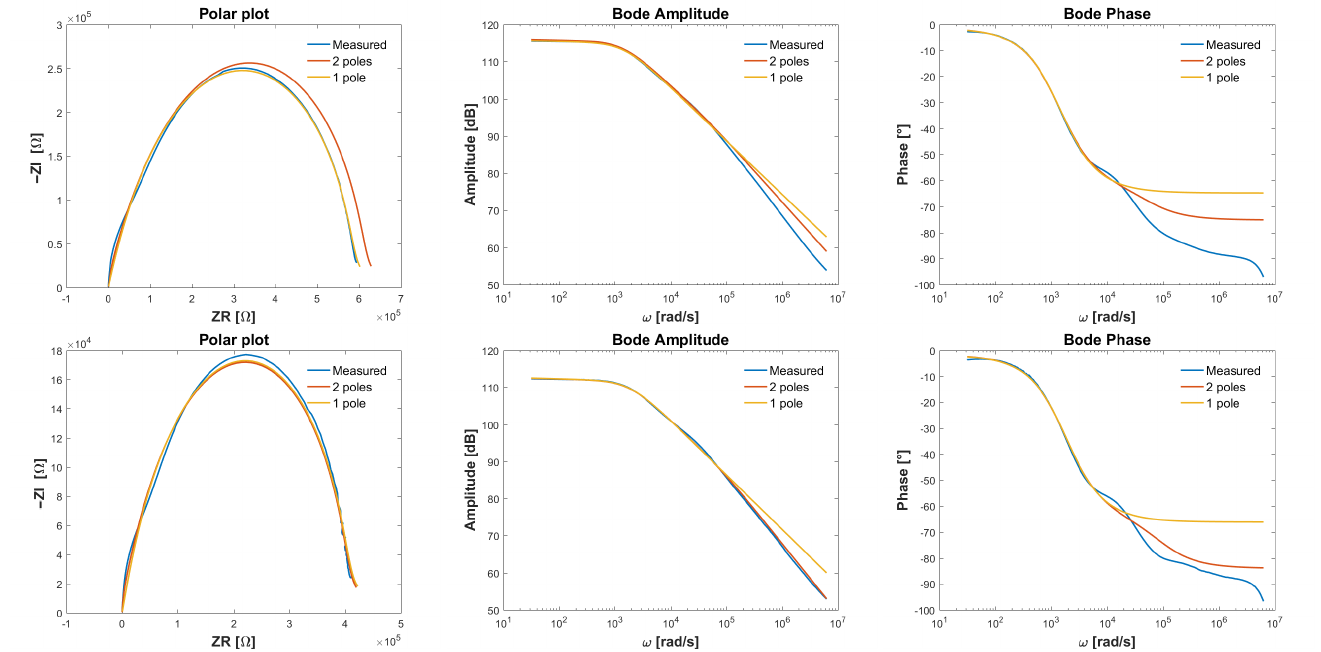
Figure 8. ( Top ) Case 1 : performance of the empirical model (23) in polar and Bode plots. ( Bottom ) Case 2: performance of the empirical model (23) in polar and Bode plots. Table 2. Reduced order model parameters (23) for two species of different viscosity. K p α β Species 1 NMSE—Normalized mean square